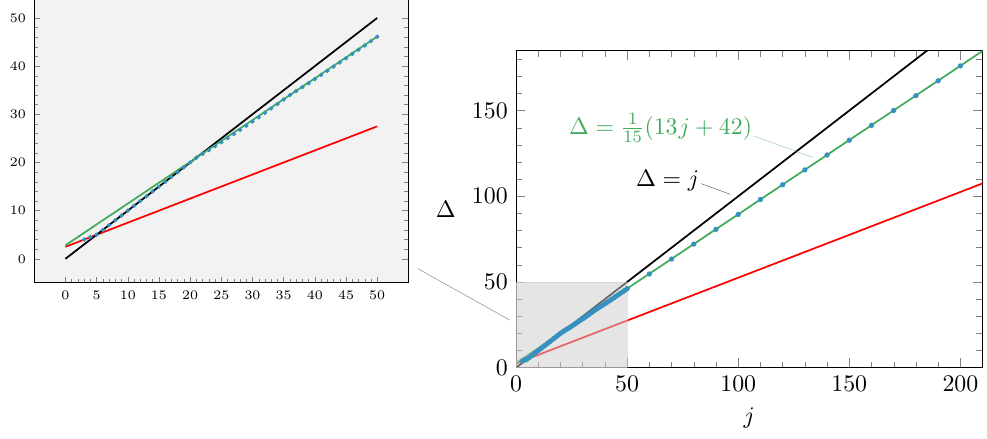
Figure 6 . Lower bounds on the conformal dimension (cid:1) as a result of the ANEC for primaries transforming in the ( 1 j; 1 ) Lorentz representation. Each point is the result of a bisection in (cid:1). The 2 2 red line is the unitarity bound, (cid:1) = 1 j + 5 . The operators for j 6 5 lie on the red line. The black 2 2 line corresponds to the conjecture of [10], (cid:1) = j , and the green line gives an approximate behavior of the bound valid above j =